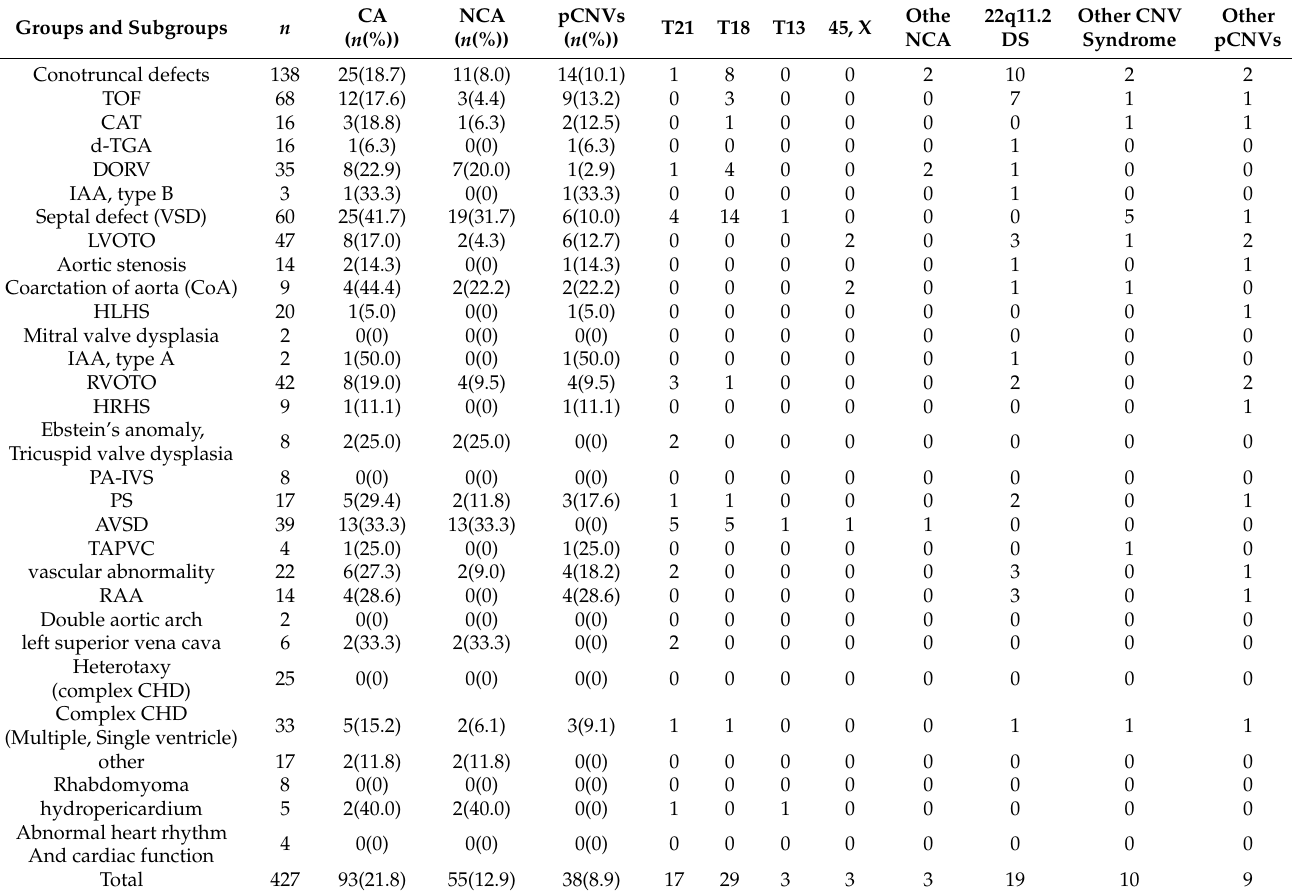
Table 3. Rate of genetic anomalies in 427 fetuses diagnosed with